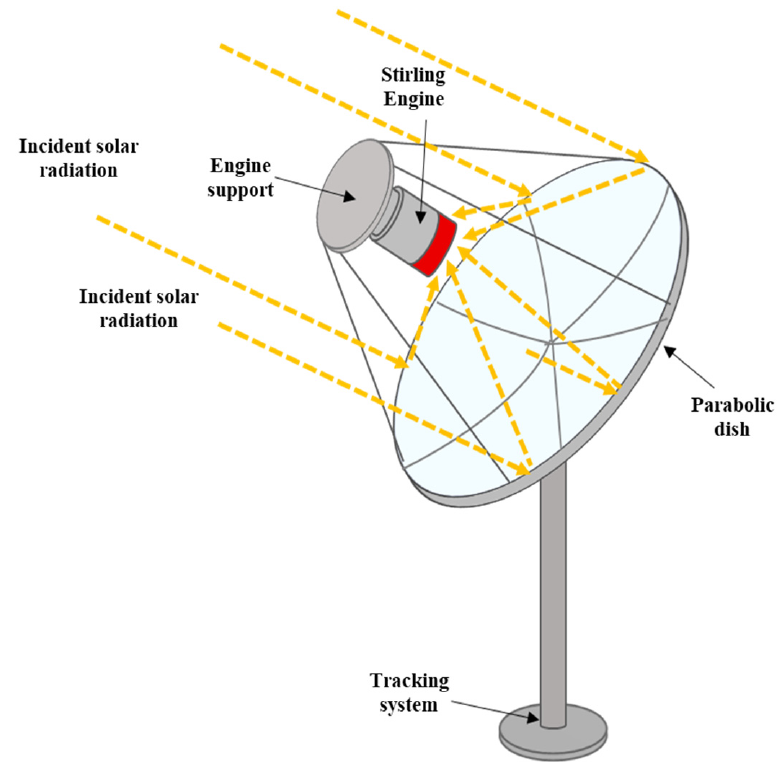
Figure 4. A schematic view of a Dish Stirling. Due to the low thermal inertia, a dish Stirling system reacts very quickly on changes in solar thermal input [23]. Thus, steady state operation is achieved within a few minutes after system start. The engines applied for dish Stirling systems use helium or hydrogen at working gas temperatures between 600 and 800 ◦ C. Power output is controlled by varying the working gas mean pressure or piston stroke